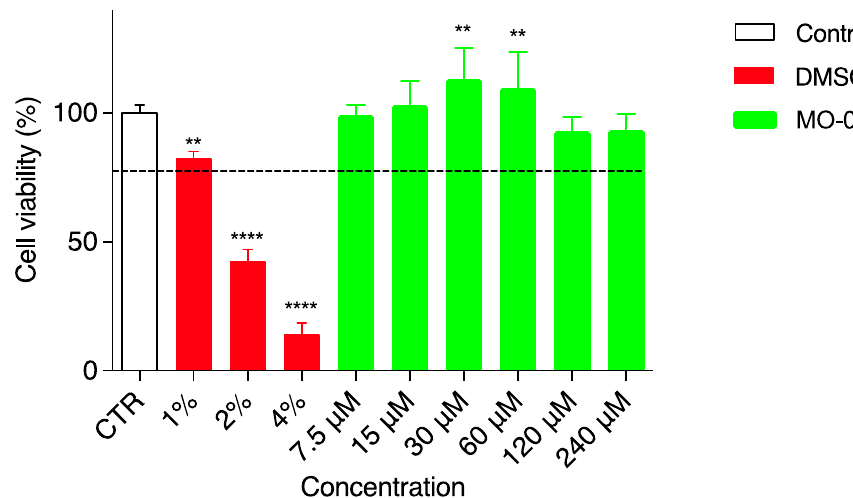
Figure 2. Viability of HaCaT cells incubated with different concentrations of MO-07 (24 h). The control is represented by untreated cells in DMEM and set at 100%; DMSO in three different percentages (1%, 2%, and 4%) was used as the positive control. The percentage of viable cells in respect to the control was reported as the mean ± SD of five independent experiments. Dotted lines indicate 80% cell viability. ** p ≤ 0.01, and **** p ≤ 0.0001 (one-way ANOVA test).